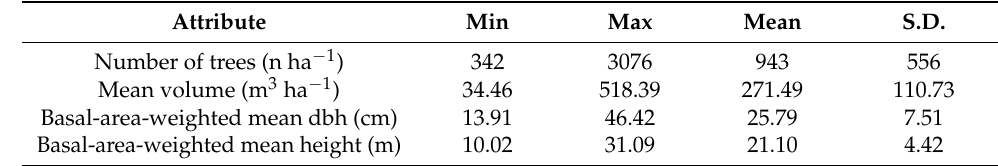
Table 1. Descriptive statistics of the field plots. The minimum (Min), maximum (Max), Mean, and standard deviation (S.D.) of the number of trees, mean volume, basal-area-weighted mean diameter, and basal-area-weighted height are reported.